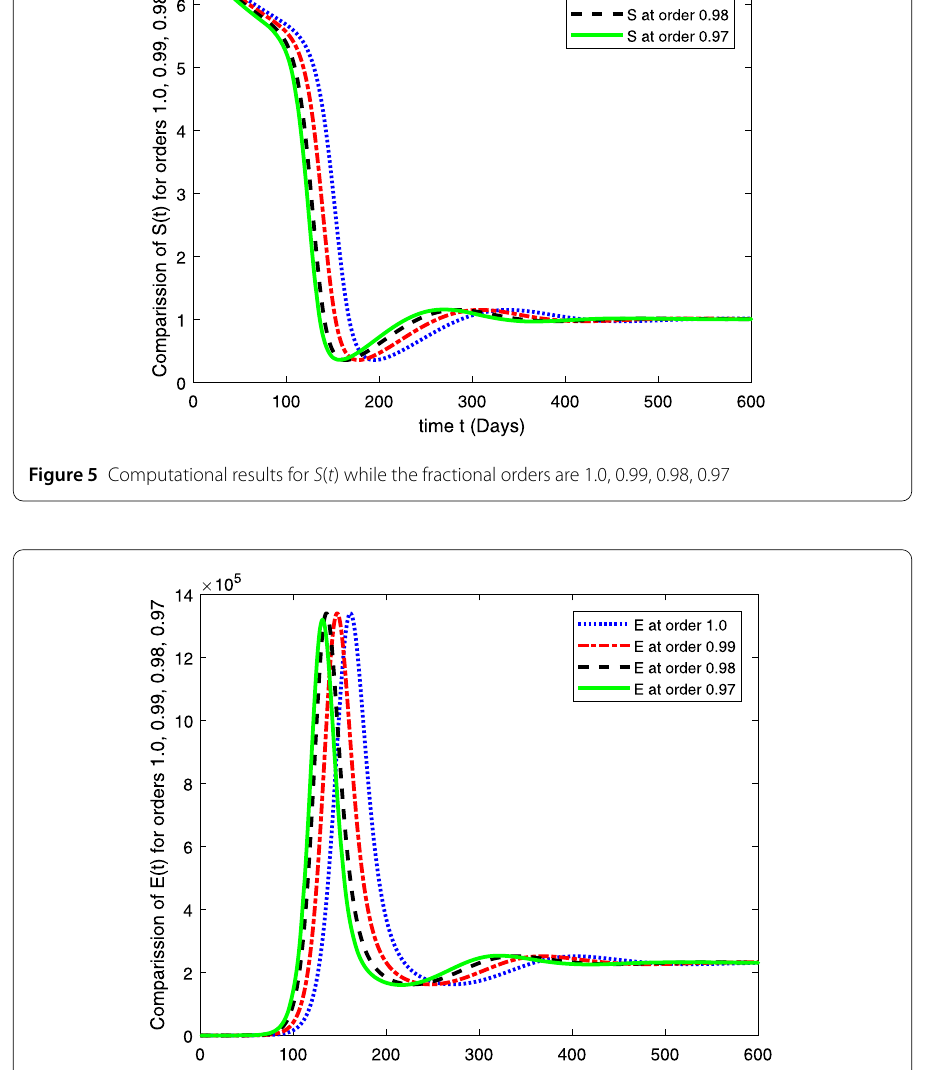
for the comparative study of S ( t ) for the different orders. Similarly, E ( t ), I s ( t ), I h ( t ), A ( t ) and R ( t ) are analysed for different fractional orders in the Figs. 6, 7, 8, 9, and 10